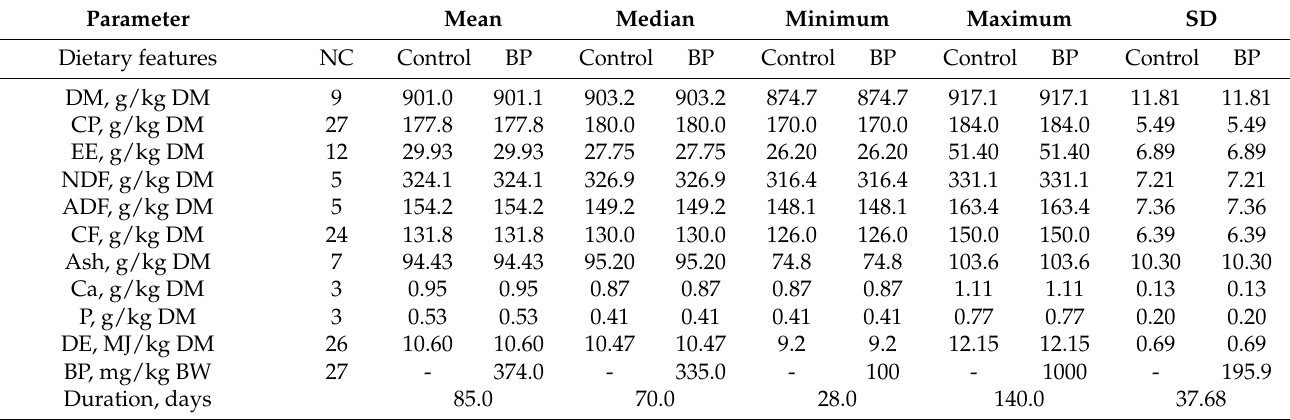
Table 1. Descriptive statistics of the complete data set for the effect of BP supplementation on rabbits’